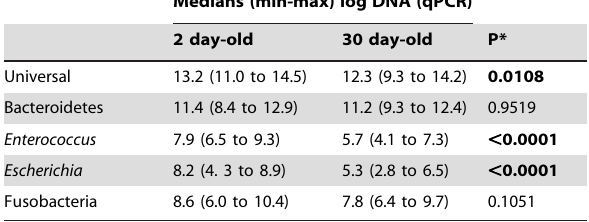
Table 5. Results of qPCR